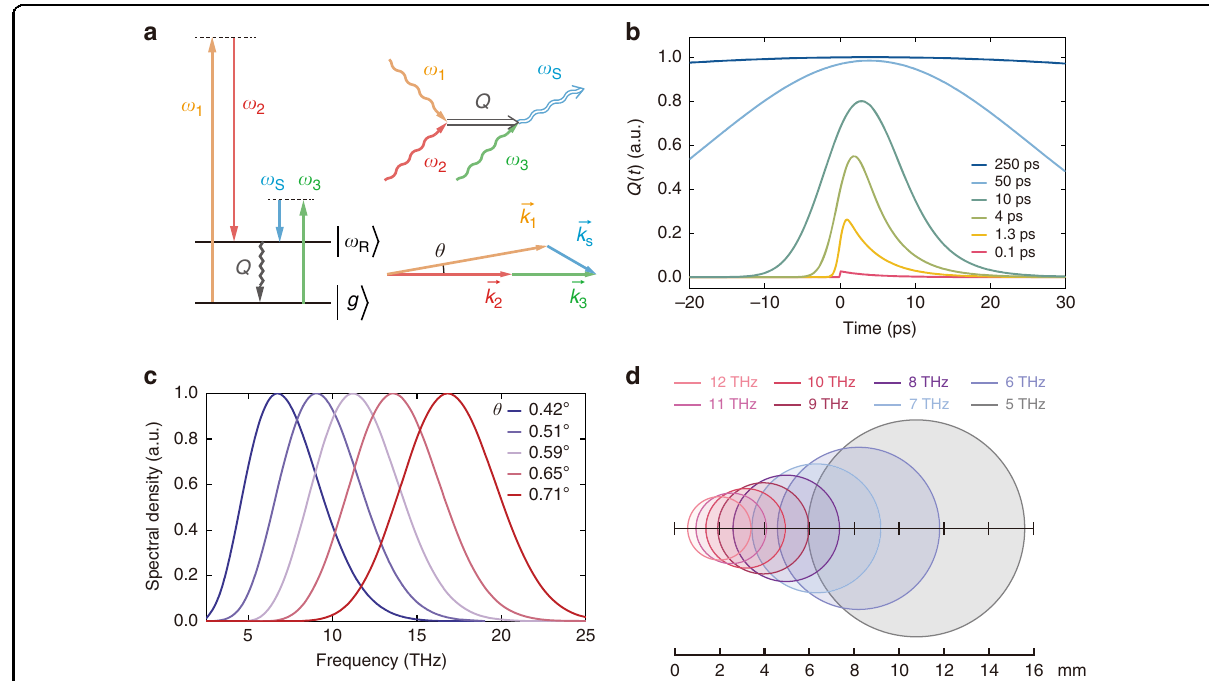
Fig. 1 THz generation by R-FWM in diamond. a Energy level diagram, Feynman diagram, and wave-vector diagram describing four-wave mixing with a Raman resonance. b Time variation of the 1332 cm − 1 vibrational wave in diamond coherently excited by ~ E 1 and ~ E 2 pulses of different pulse widths. c Calculated THz output spectra at selected θ . d Calculated spatial distributions of different frequency components in the collimated THz output beam for the case of θ = 0.42° in c ; each circle describes a Gaussian distribution cut off at e − 2 of the